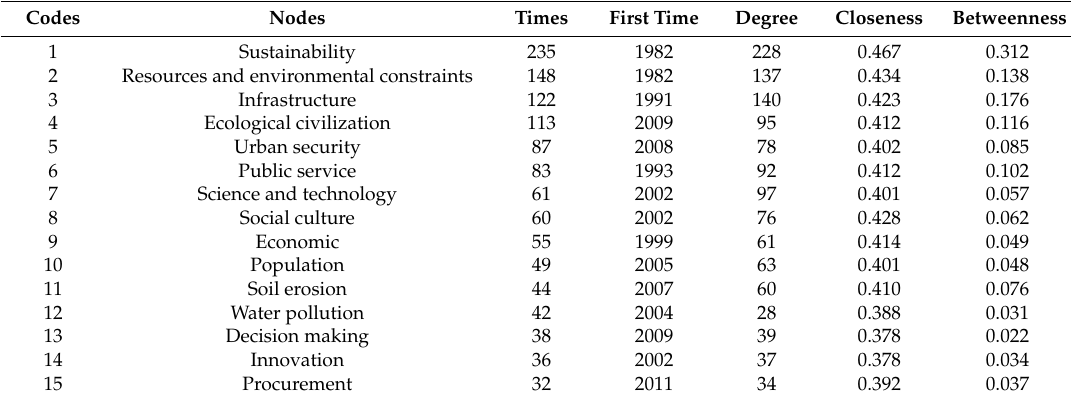
Table 2. The attributes of nodes of the urban comprehensive carrying capacity network.